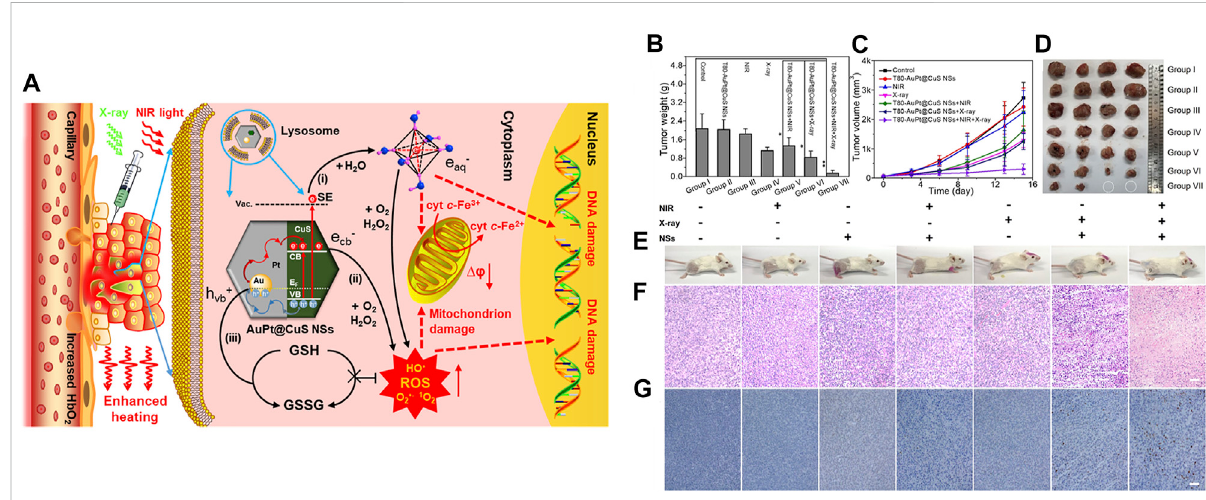
FIGURE 2 (A) Schematic representation of AuPt@CuS NSs for enhanced synergistic radio-photothermal therapy, (B) weights of dissected tumors from eachgroup, (C) relativetumorvolumesaftervarioustreatments( n =4), (D) digitalphotographsofthedissectedtumors, (E) photographsofmiceafter treatment. (F,G) H&E-stained images of tumor sections following treatment. Reproduced with permission (Cai et al., 2021). Copyright 2021, American Chemical